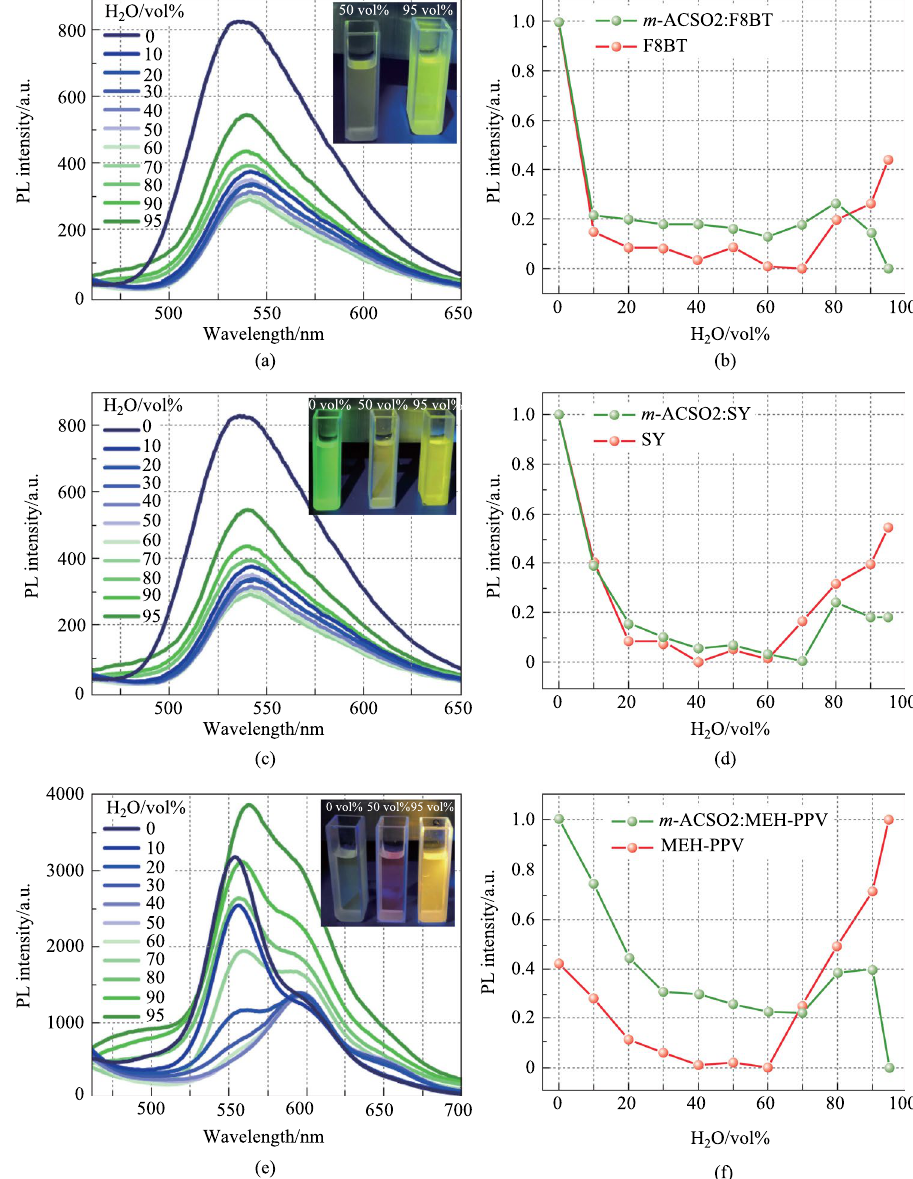
–5 mol/L). Inset: Photos of different 2 O (10